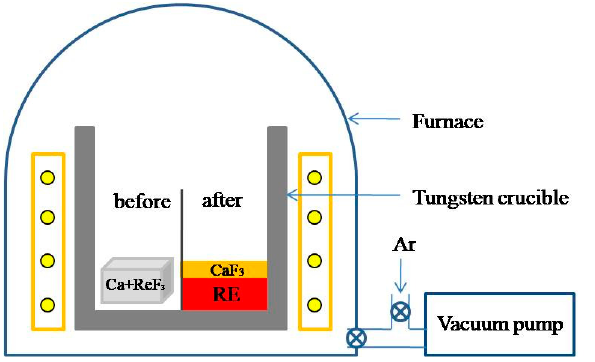
Figure 4. Schematic diagram of metal thermal reduction.